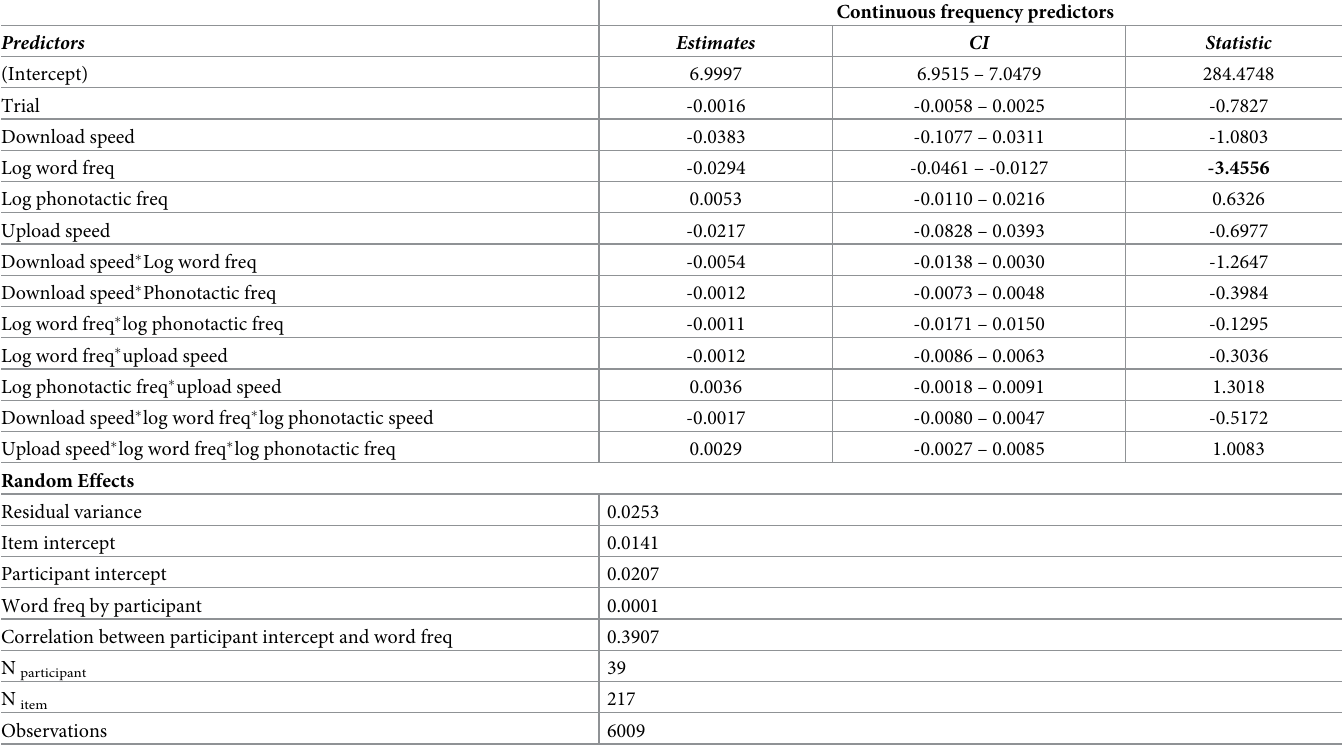
Table 4. Linear mixed model outputs of internet speed affecting latency, with continuous frequency predictors.